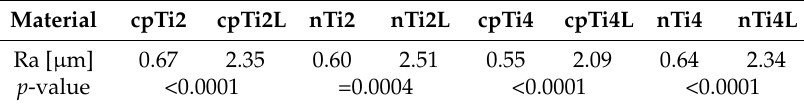
Table 2. Arithmetical mean roughness Ra values for all types of samples.